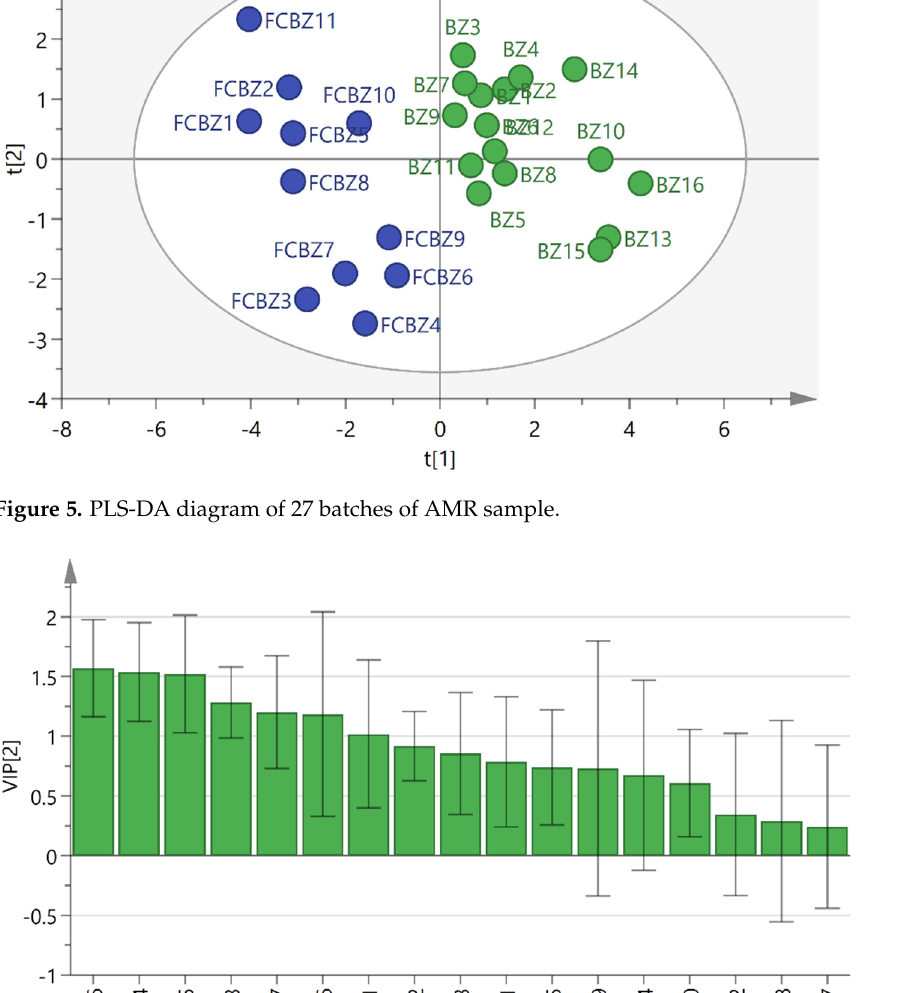
Figure 6. VIP diagram of 27 batches of AMR sample.